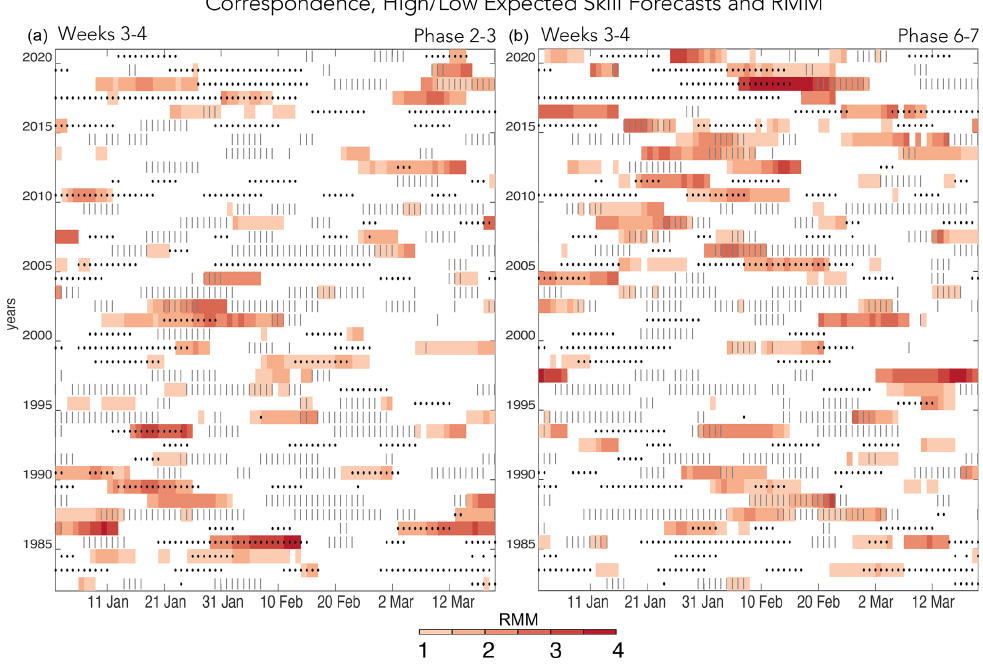
Figure 8. As in Fig. 6 but for the amplitude of the RMM index during (a) MJO phases 2–3 and (b) MJO phases 6–7 and for weeks 3–4 expected-skill dates.